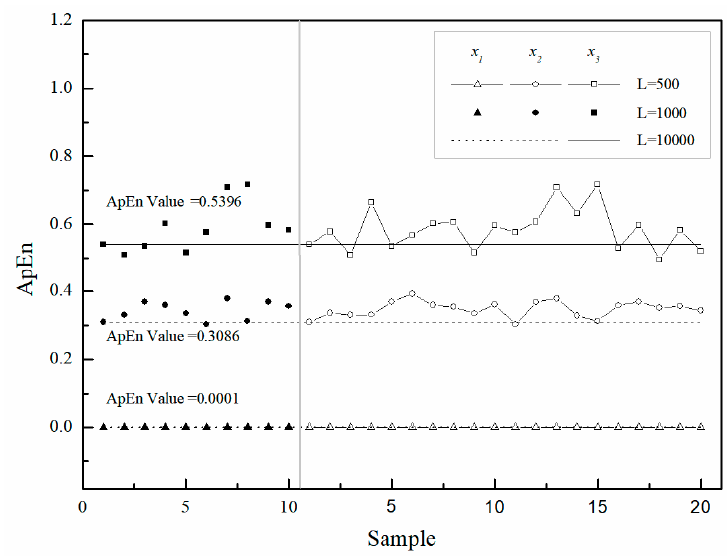
Figure 3. The ApEn values of sub ‐ series with lengths of 10,000, 1000 and 500. The value of parameter L represents the length of sub ‐ series.